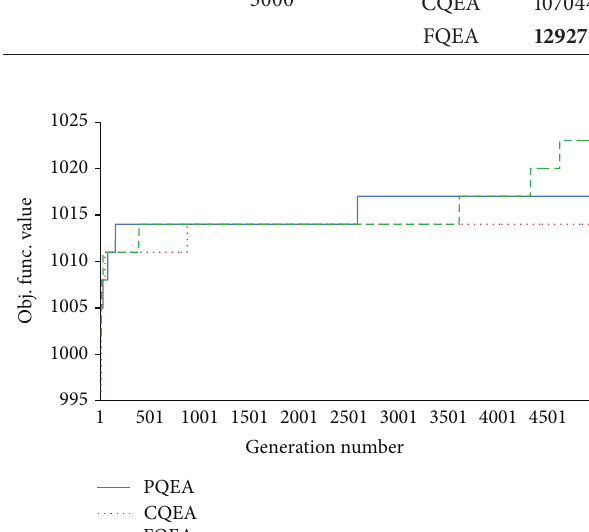
Figure 34: Convergence graph of PQEA, CQEA, and FQEA on 0-1 knapsack problem with profit ceiling data instances with number of items, 𝑀 , being 5000 and capacity, 𝐶 , being 1% of total